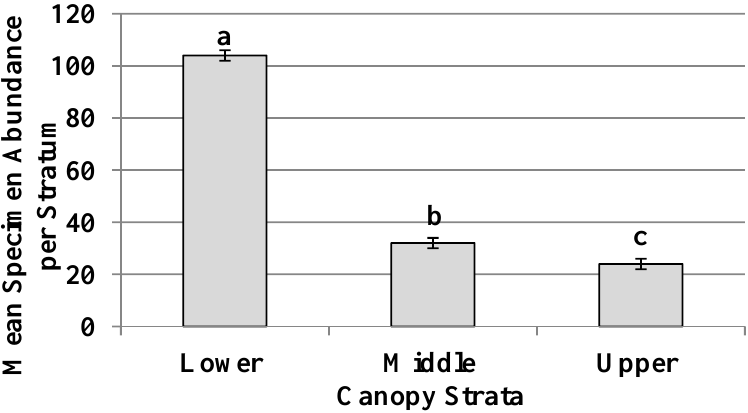
Figure 1. Mean specimen abundance (mean number of individuals ± SE) for each stratum. Different lower case letters above standard error bar indicate differences among strata (LSD test; p > 0.05).